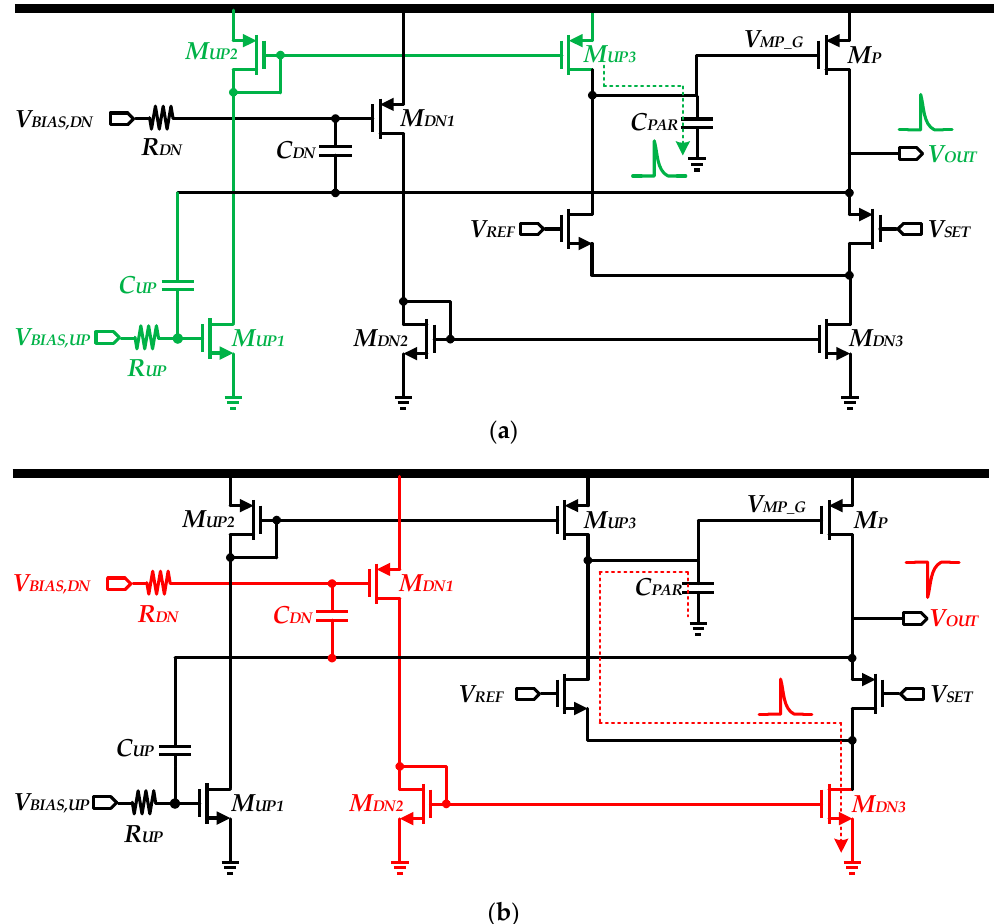
Figure 5. Operation principle of voltage spike detection FVF-based LDO regulator. ( a ) under overshoot condition; ( b ) under undershoot condition.